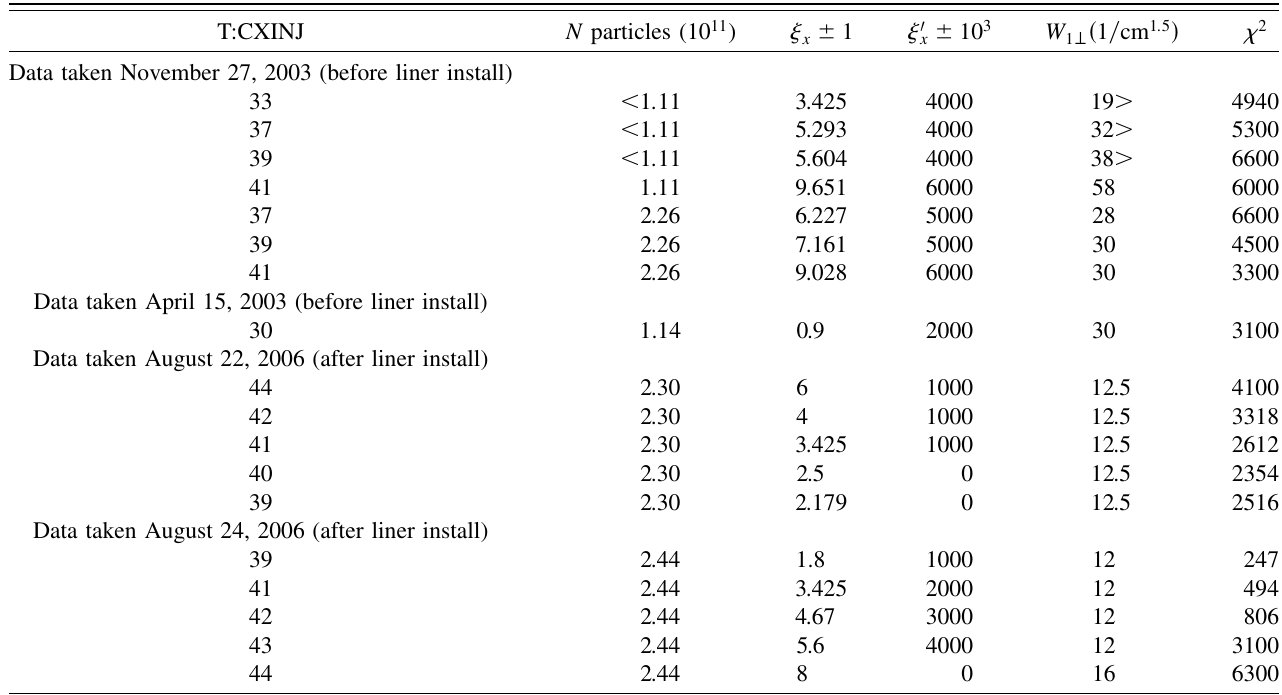
TABLE I. Horizontal fits to turn-by-turn